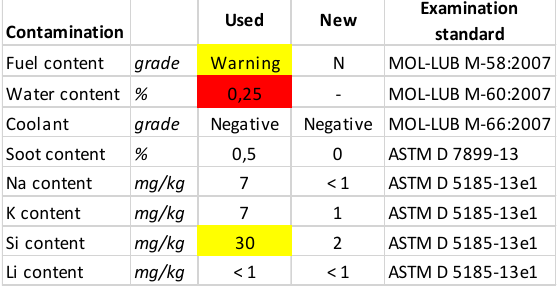
Figure 11: Table showing the comparison about pollutants found in oils Examination parameters in the 1 st column, units are in the 2 nd , values belonging to the 1000 km ran, used oil are in the 3 rd column and values belonging to the new oil are in the 4 th It is readable from the table above also, what we have previously mentioned, that the fuel and water con– tent of the oil is significantly high. Both of the values are indicated with warning signal by the